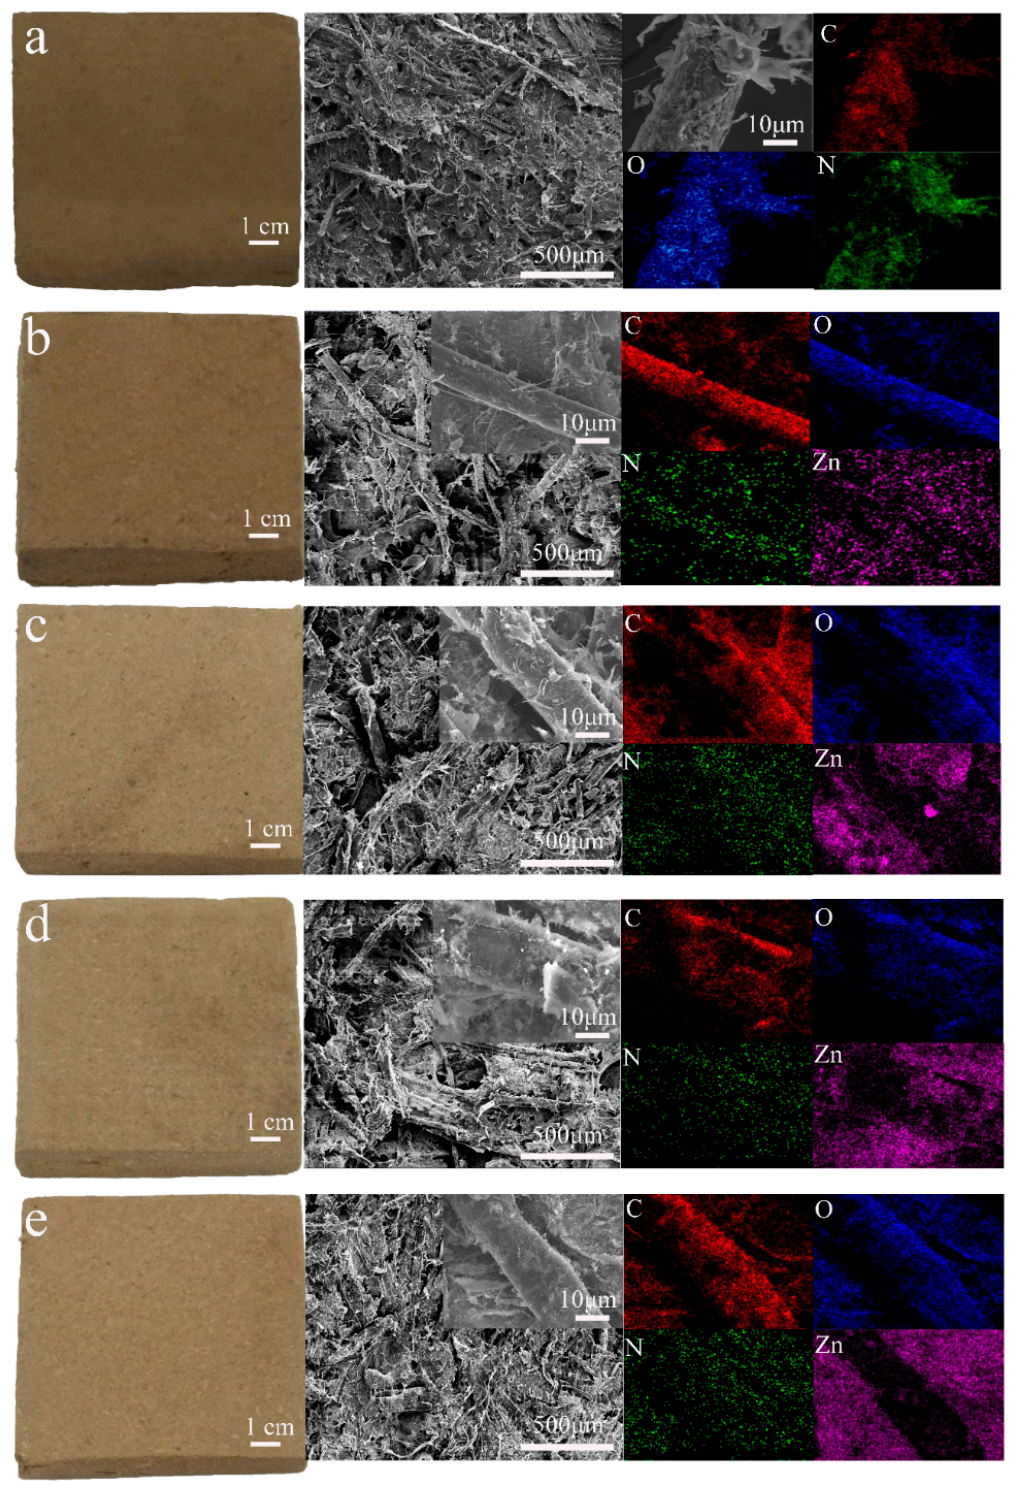
Figure 1. A digital image, SEM, and EDX mapping of the PE/wood-fiber composite and of the PE/ZnO/wood-fiber composite (PZW). ( a ) PZW0; ( b ) PZW1; ( c ) PZW2; ( d ) PZW3; ( e ) PZW4.